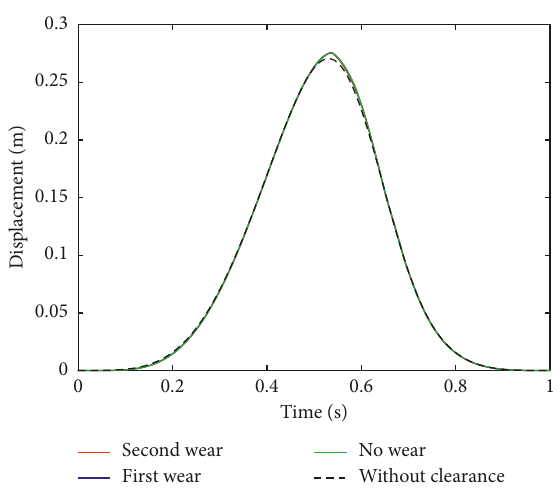
Figure 15: Slider’s displacement.